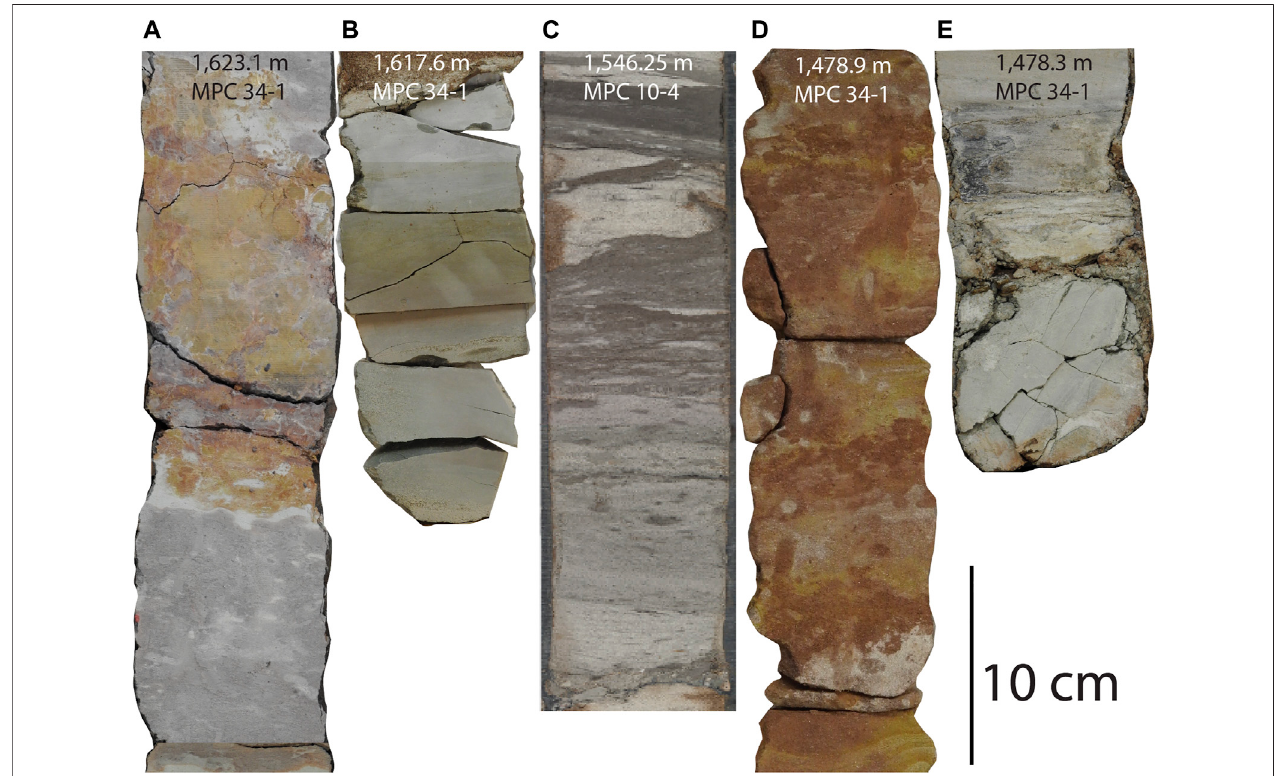
FIGURE5| Corephotographs ofmudstone-bearing rocks inthePaluxy Formation and the Washita-Fredericksburg interval intheMPC 10-4 and MPC34-1 wells. (A) Variegated mudstone facies, 1,623.1 m (5,325 ft) in the MPC 34-1 well. (B) Massive mudstone facies, 1,617.6 m (5,307 ft) in the MPC 34-1 well. (C) Heterolithic mudstone facies, 1,546.25 m (5,073 ft), in the MPC 10-4 well. (D) Variegated and blocky mudstone facies, 1,478.9 m (4,852 ft), with interbedded sandstone and variegated color in the MPC 34-1, Washita-Fredericksburg interval. (E) Blocky gray peds in the variegated and blocky mudstone facies 1,478.3 m (4,850 ft), in the MPC 34-1, Washita-Fredericksburg interval.